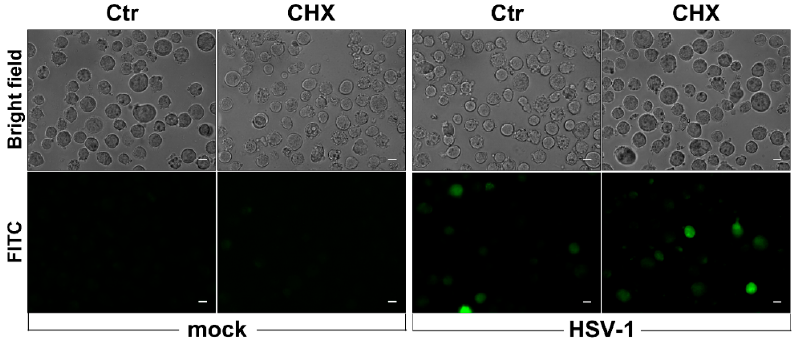
Figure 5. Effects of cycloheximide (CHX) treatment on early ROS induction by HSV-1. U937 cells, pretreated with CHX 1 µg/mL or with vehicle alone (Ctr) for 1 h, were loaded with DCFH-DA before exposure to HSV-1 (MOI = 50 PFU/cell) for further 30 min and successive fluorescence microscopy analysis. Representative images in bright-field and FITC channel are shown (40× objective, Zeiss Observer Z1 microscope). Scale bar = 10 µm.